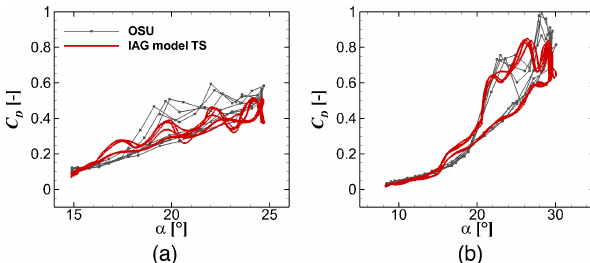
Figure 20. Lift reconstruction by the IAG model in comparison with the measurement data (Ramsay et al., 1996) for (cid:49)t = T/ 1440 using the actual angle of attack in the experimental campaign at various (cid:49)α values. (a) (cid:49)α = 5 . 5 ◦ ; (b) (cid:49)α = 10 ◦ . S801 airfoil, k = 0 . 073 and α = 20 ◦ .